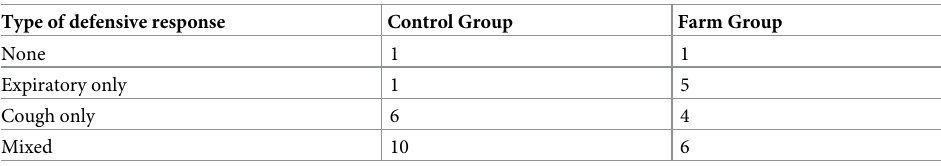
Table 1. Type of defensive